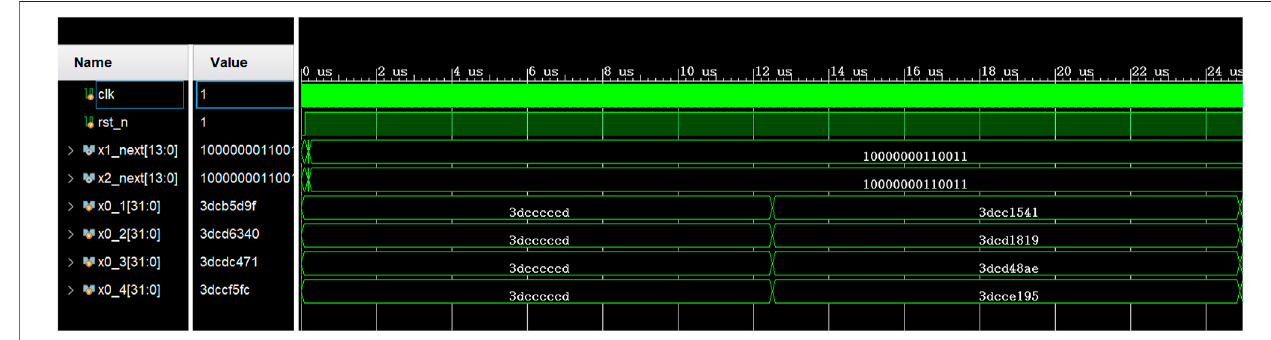
FIGURE 6 | The behavior simulation results given by the vivado platform simulator.